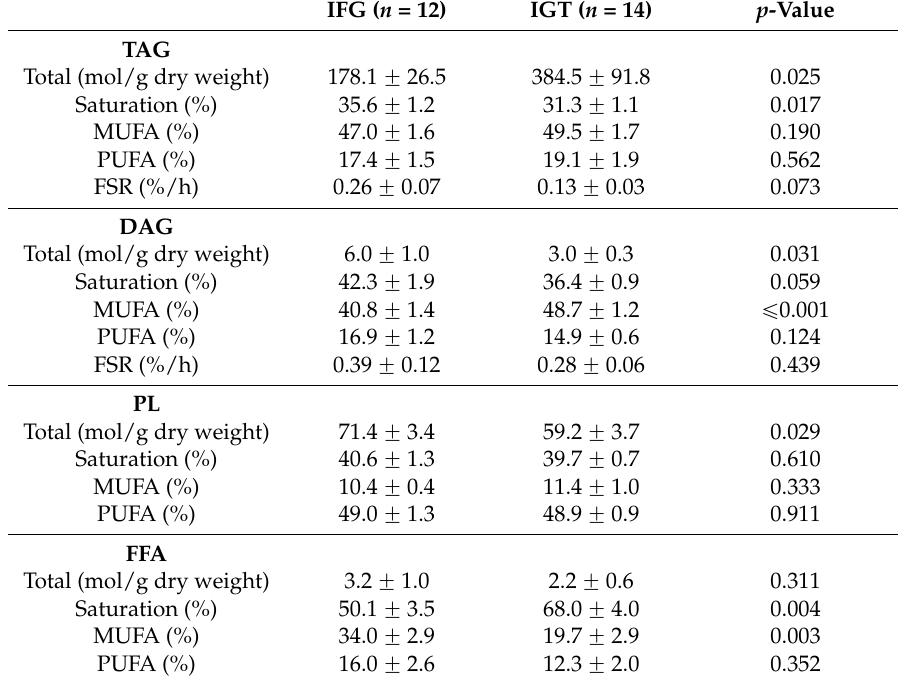
Table 4. Fasting skeletal muscle lipid content, composition and fractional synthetic rate after a high-fat